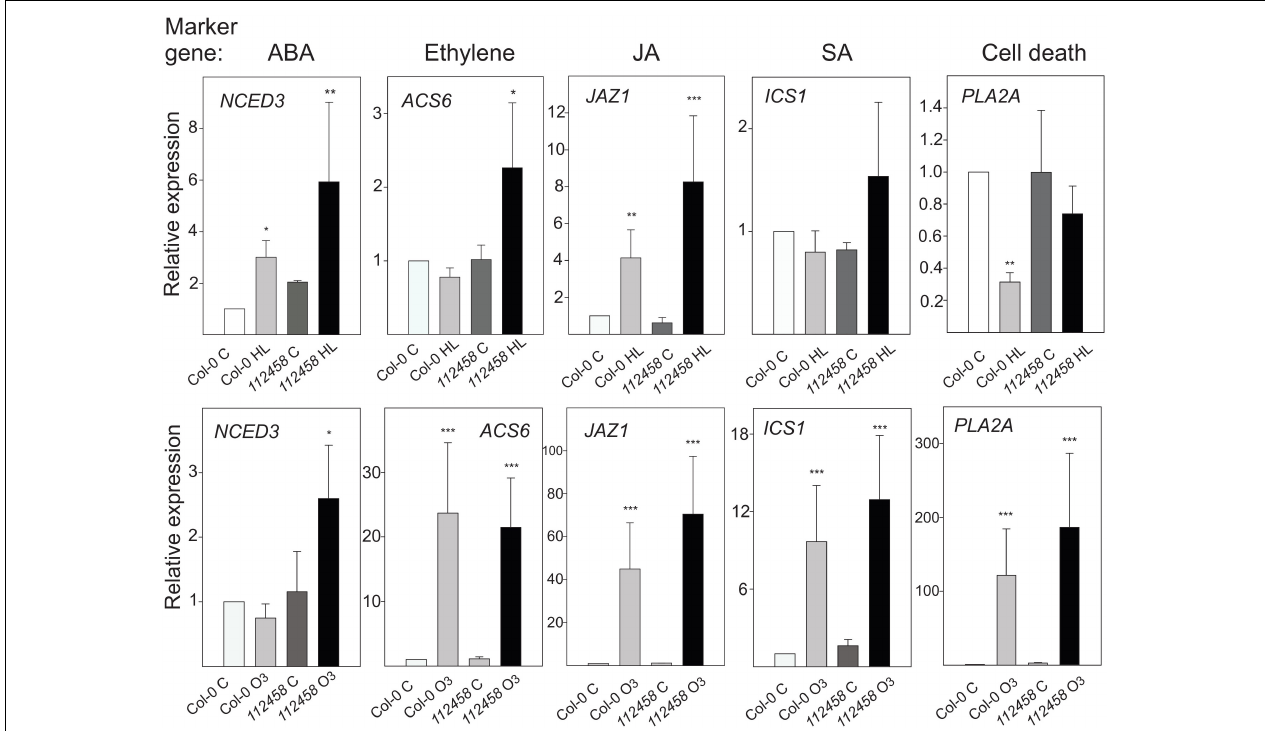
FIGURE 5 | Relative expression scaled to the Col-0 control (set to 1), after 1 h HL (growth condition Turku, Table 1 ) or 1 h O 3 (350 nL L − 1 , growth condition Helsinki-1) in Col-0 and pyr/pyl112458 . The average of three biological replicates are shown; error bars depict standard deviation. Two-way ANOVA with Tukey’s test was used for statistical analysis and depicts significant differences compared to Col-0 control (* P < 0.05; ** P < 0.01; *** P <